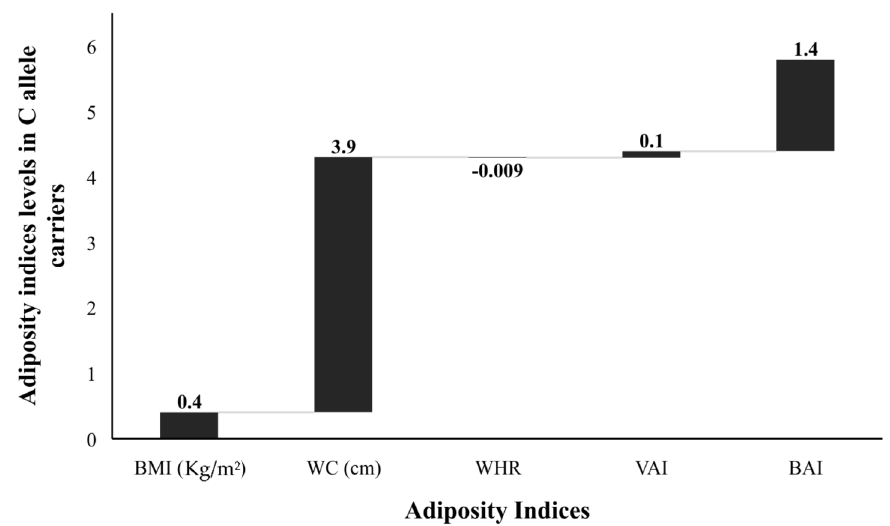
Figure 6. Adiposity indices levels (SD change from population means) in C allele carriers. The levels of all adiposity indices (BMI, body mass index; WC, waist circumference; WHR, waist-hip ratio; VAI, visceral adiposity index; and BAI, body adiposity index presented as standard deviation (SD) change from the population means in C allele carrier (GC heterozygotes and CC homozygotes combined) from that of G allele carrier (GG homozygotes) study subjects. The bars with +ive (>0) values represent higher/raised levels while those with − ive (<0) values show lower levels of individual variables in C allele carriers as compared with the G allele carriers.